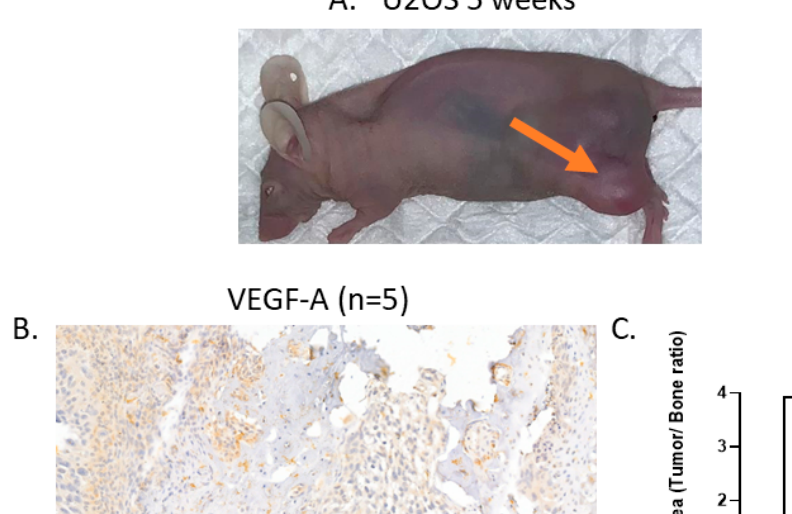
Figure 4. High VEGF-A and FGF2 labeling levels in an orthotopic OS mouse model and in human lung metastasis specimens: ( A ) U2-OS tumor image at 5 weeks and ( B ) anti-VEGF-A immunolabel- ing. Representative images of primary OS tumors in mice and nearby bone. The labeling pattern